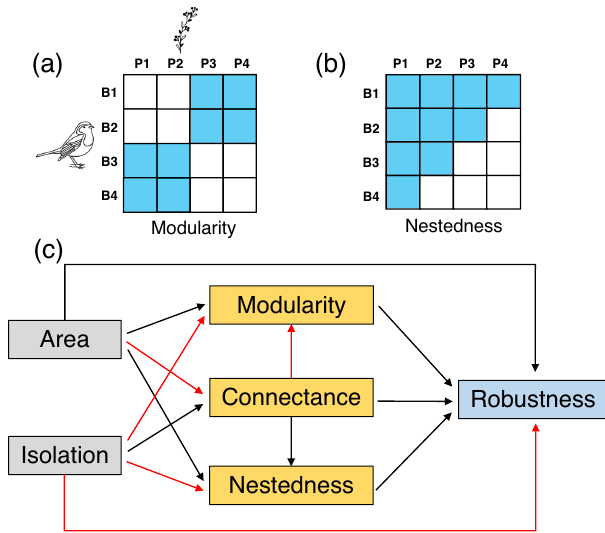
Fig. 4 Illustration of two network structures and the hypotheses. a A perfectly modular structure, where modules of species interact more closely with each other, and b a perfectly nested structure, where specialist species (e.g., B4 or P4, where ‘ B ’ indicates ‘ Bird ’ , and ‘ P ’ indicates ‘ Plant ’ ) interact with a subset of partners of generalist species (e.g., B1 or P1). Blue cells indicate interactions between bird and plant species, while white cells do not. c All potential hypothesised effects of habitat fragmentation (island area and isolation) on the structures (connectance, modularity and nestedness) and robustness of plant- frugivore networks. Black and red lines indicate positive and negative effects,